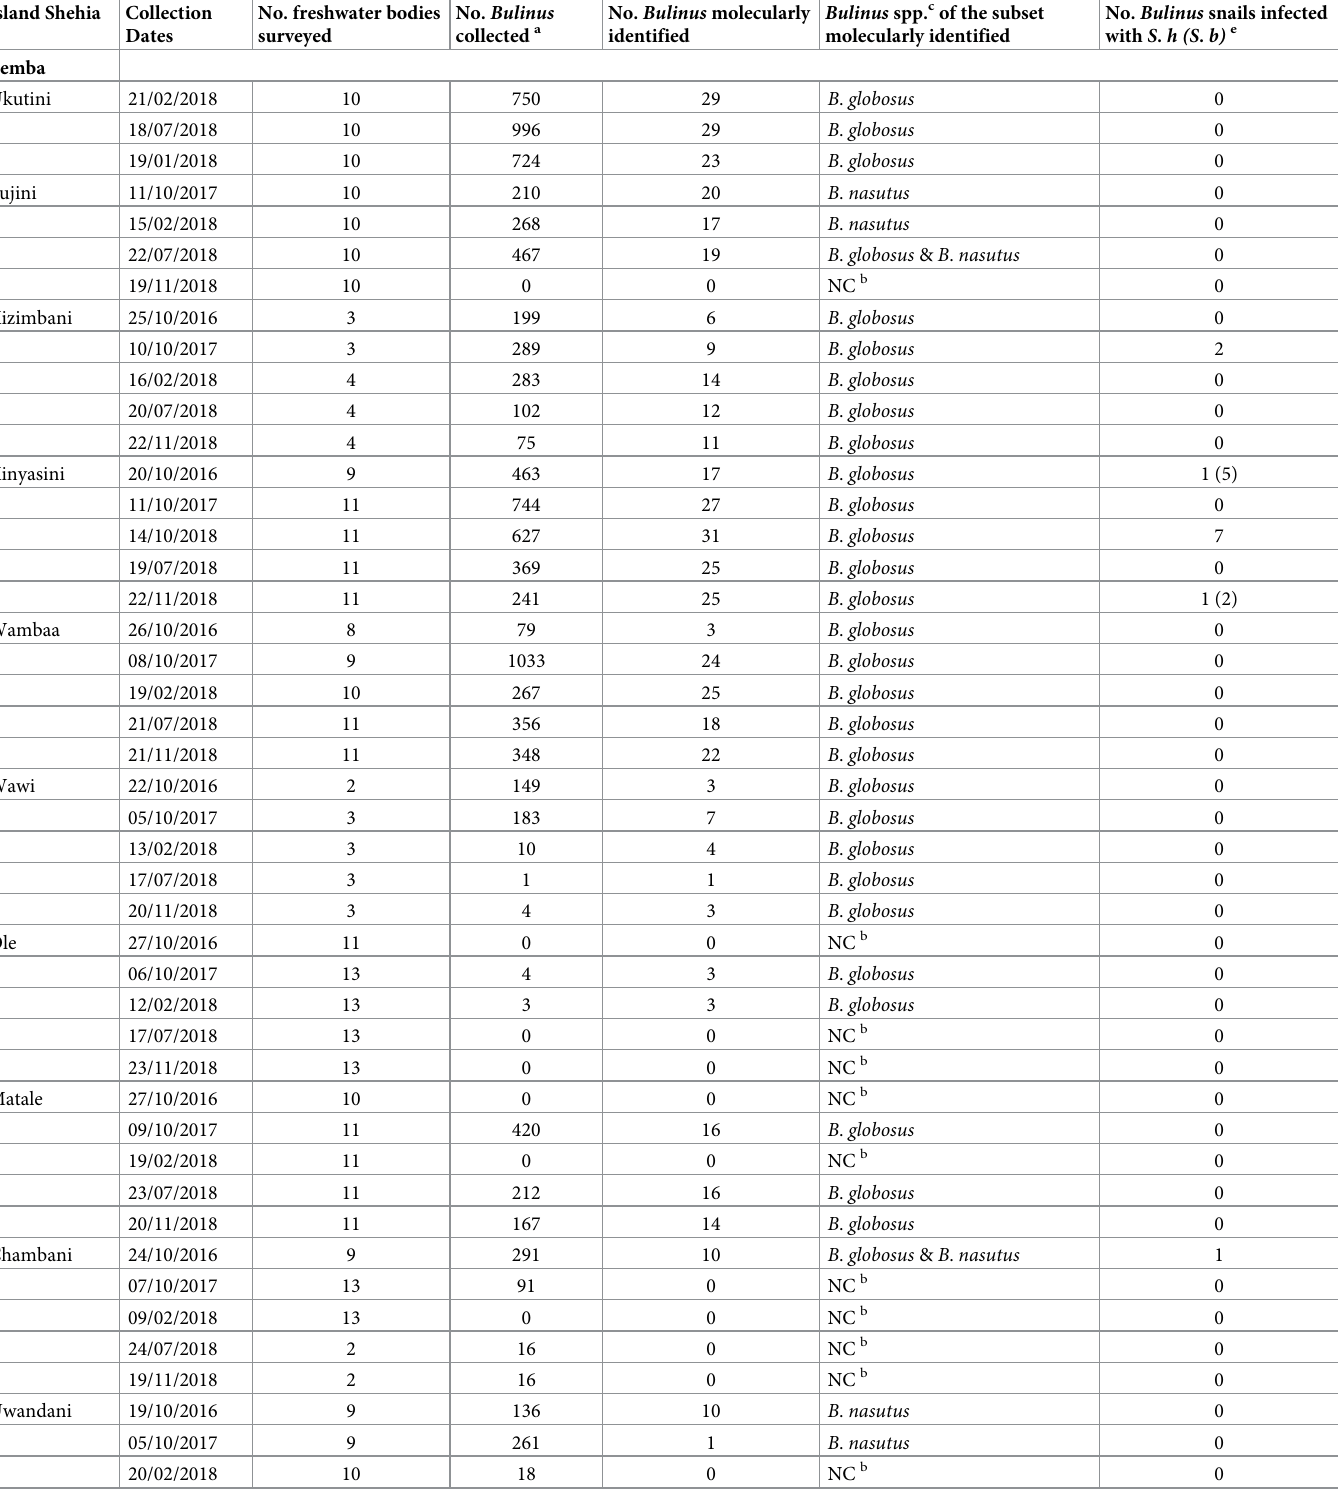
Table 1. Bulinus spp. collected in Pemba and Unguja islands (Zanzibar, United Republic of Tanzania) and samples analysed from previous collections and curated within the Schistosomiasis Collection at the Natural History Museum (SCAN). Island Shehia Collection